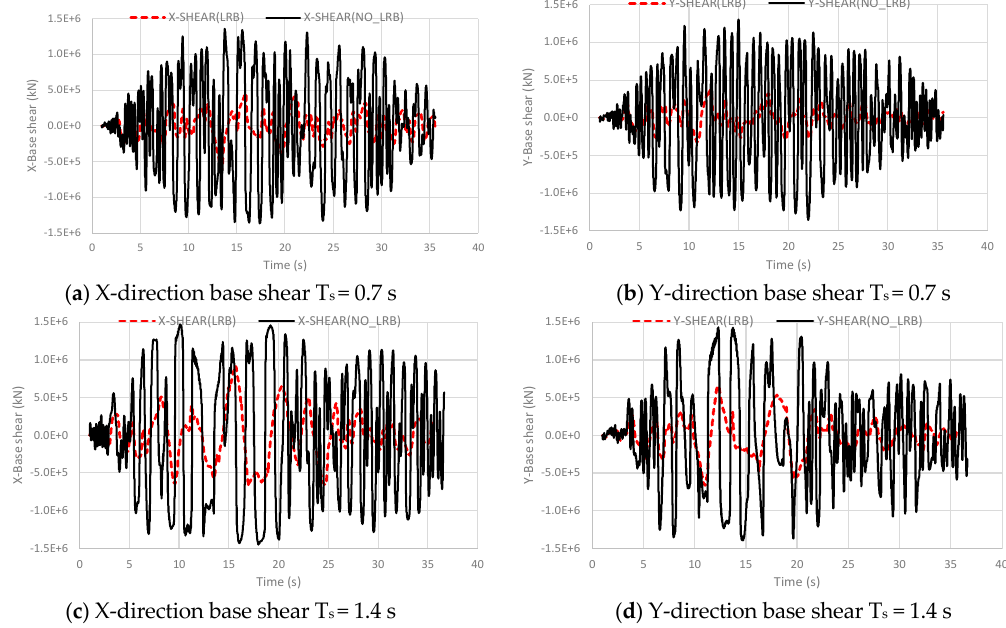
Figure 7. Comparison of base shears between the factory with and without LRBs under the seismic load of PGA = 0.32 g and T s = 0.7 s and 0.14 s.